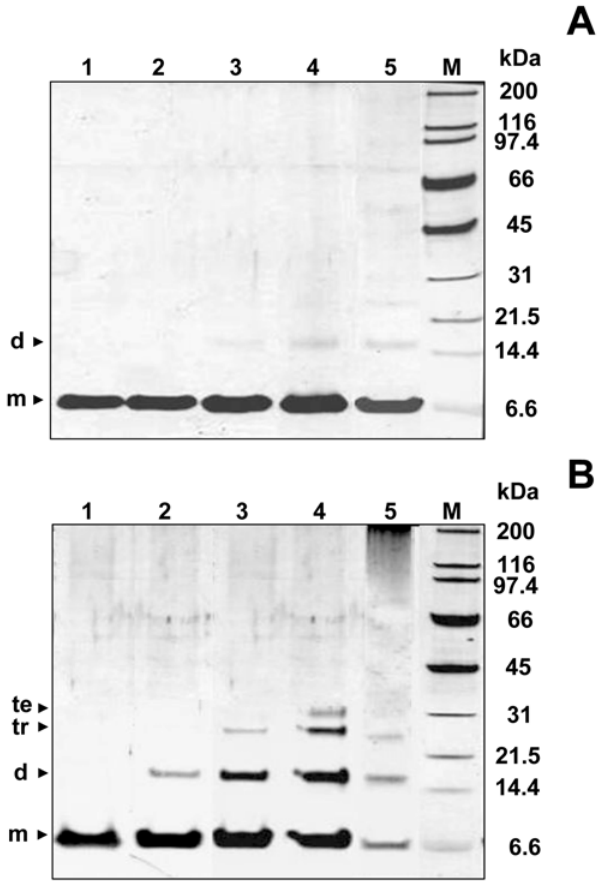
Figure 2. Analysis of Cu II -stabilized Ub oligomers. SDS-PAGE analysis of Ub incubated at 37 u C in the absence of Cu II (A) and with 3 mol equiv of Cu II (B) at different incubation time intervals: 2 h ( lane 1 ), 3 d ( lane 2 ), 1 w ( lane 3 ), 2 w ( lane 4 ), 2 mo ( lane 5 ).